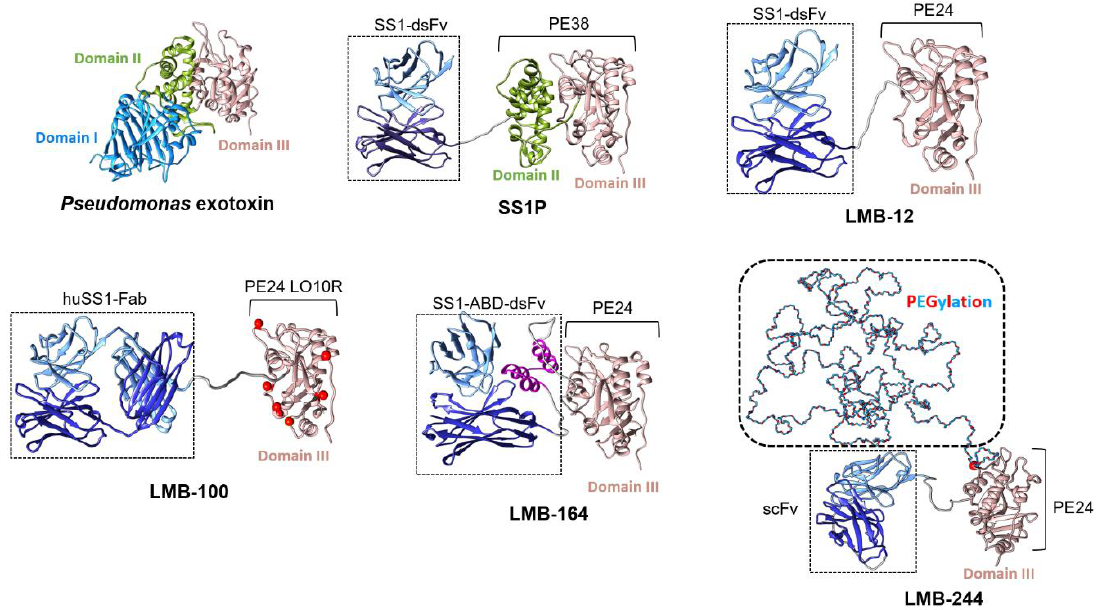
Figure 1. Structures of mesothelin (MSLN)-targeted recombinant immunotoxins (iToxs). Pseudomonas exotoxin (PE) contains three domains: domain I (binding), domain II (linker), and domain III (catalytic). SS1P was engineered with a MSLN-targeted dsFv (SS1) fused to PE38, containing domains II and III of PE. LMB-12 was formed by attaching SS1 to PE24 (only furin cleavage site of domain II remains from PE38), in an e ff ort to eliminate T cell epitopes. LMB-100 contains a humanized anti-MSLN Fab linked to a modified PE24, designed to eliminate remaining B cell epitopes. The red balls in the model indicate individual residues that were mutated during the technical deimmunization. LMB-164 is a derivative of LMB-12, with insertion of an albumin binding domain, shown in lavender. Finally, LMB-244 consists of a single chain Fv (scFv), linked to PE24 that contains a cysteine site-specific PEGylation on the PE24 molecule. The PE38 structure is the X-ray crystallograph of wild type PE structure (PDB:1IKQ). All other iToxs are modeled from the crystal structure of mesothelin and antibody complex (PDB: 4F3F) with the PE38. LMB-164 includes the albumin binding domain modeled from the one in Streptococci (PDB: 1GJS). The domain III of PE with substrate NAD and AMP (PDB: 1DMA) and the complex structure of PE and Elongation factor 2 (PDB: 1ZM4) were superposed to iToxs models, to avoid potential binding interference when